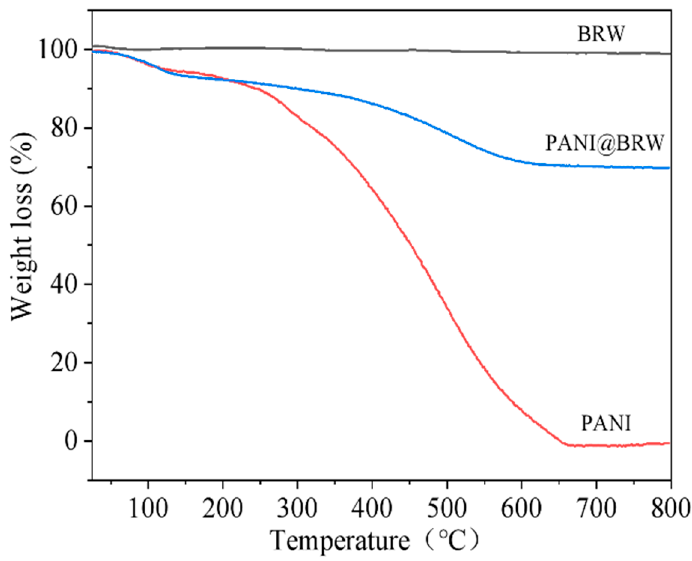
Figure 7. Thermogravimetric analysis (TGA) diagrams of BRW, PANI, and PANI@BRW.